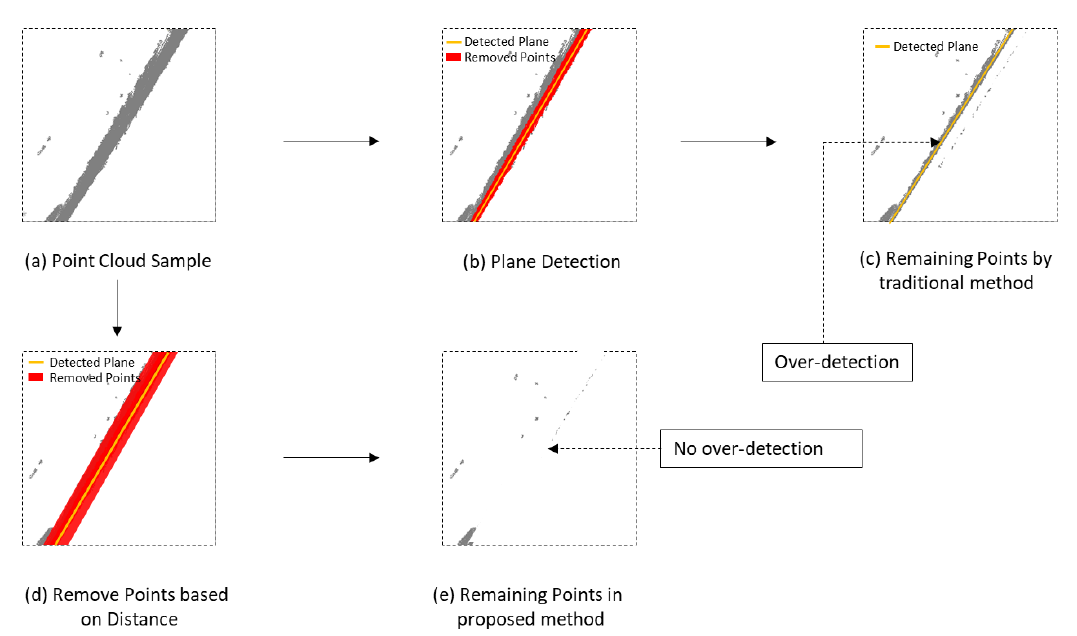
Figure 8. Description of the over-detection problem and the solution used in this paper.